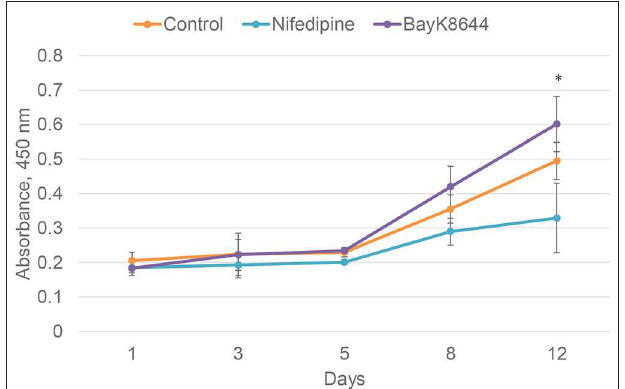
FIGURE 1 | Proliferation of chondrocytes after the treatment with nifedipine (10 µ M) and BayK8644 (10 µ M) for 1, 3, 5, 8, and 12 days. CCK-8 viability and cytotoxicity assay. The absorbance of reduced formazan dye, produced by living cells, is presented. Absorbance measured at 450nm. * p < 0.05.